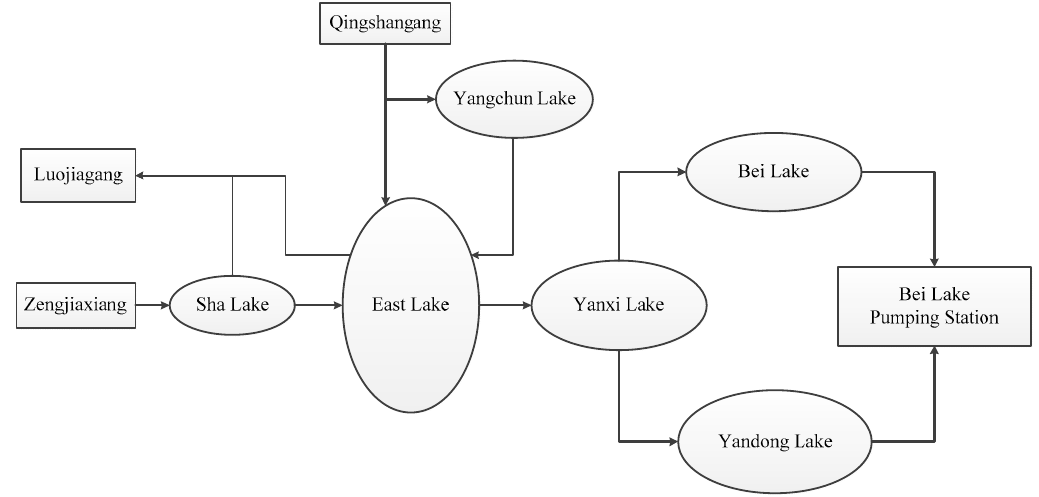
Figure 4. Diversion channels of the East Lake Network.